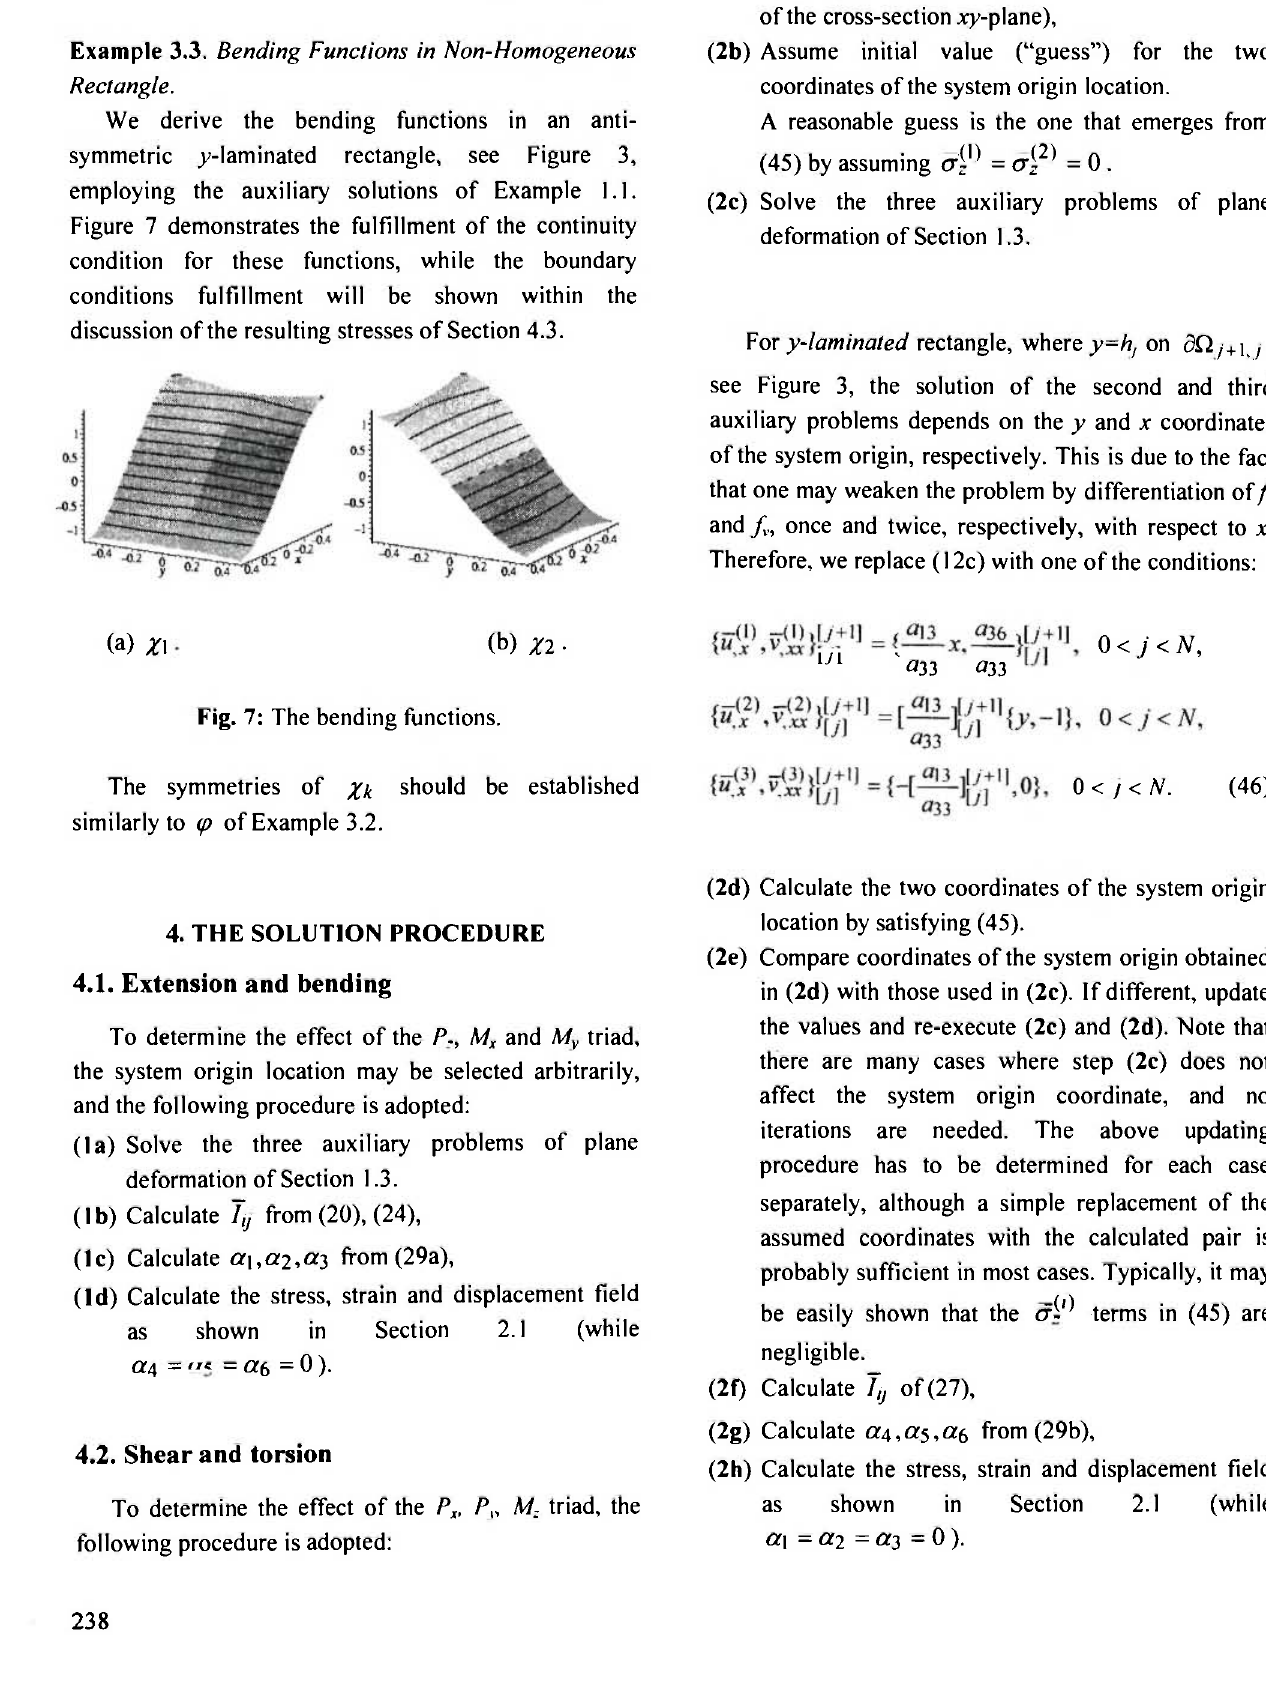
Fig. 7: The bending functions. The symmetries of Xk should be established similarly to ψ of Example